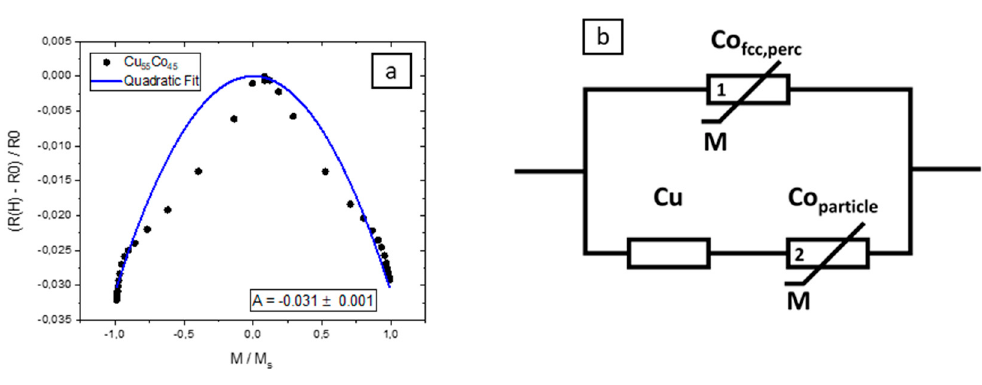
Figure 13. ( a ) Quadratic fit of room temperature GMR data for Cu 55 Co 45 in accordance with reference [4]. ( b ) Schematic representation of electron conduction channels in case of Cu 55 Co 45 , consisting of Cu, containing Co-particles on the one side and Co enriched, percolating areas on the other side.